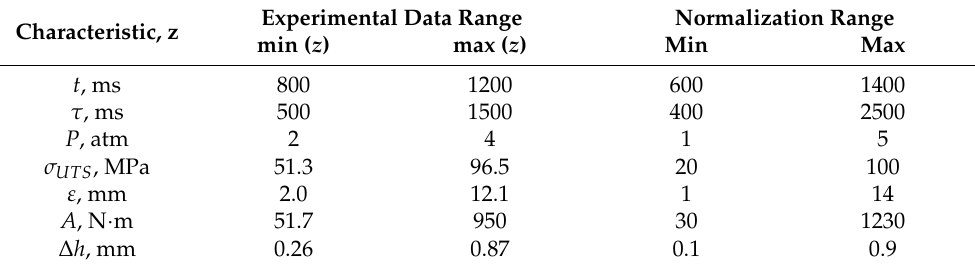
Table 4. Parameter and property values based on analysis results.